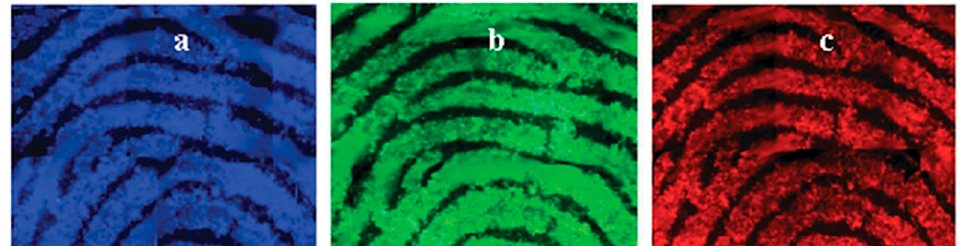
Figure 3. Fluorescence microscopy images of fingerprints deposited on a glass slide and visualised with 0.7% C-dot–silica hybrid nanopowder under ( a ) violet, ( b ) blue and ( c ) green light. The images are composites of smaller images combined using Adobe Photoshop. Reproduced from reference [40] with permission of The Royal Society of Chemistry.